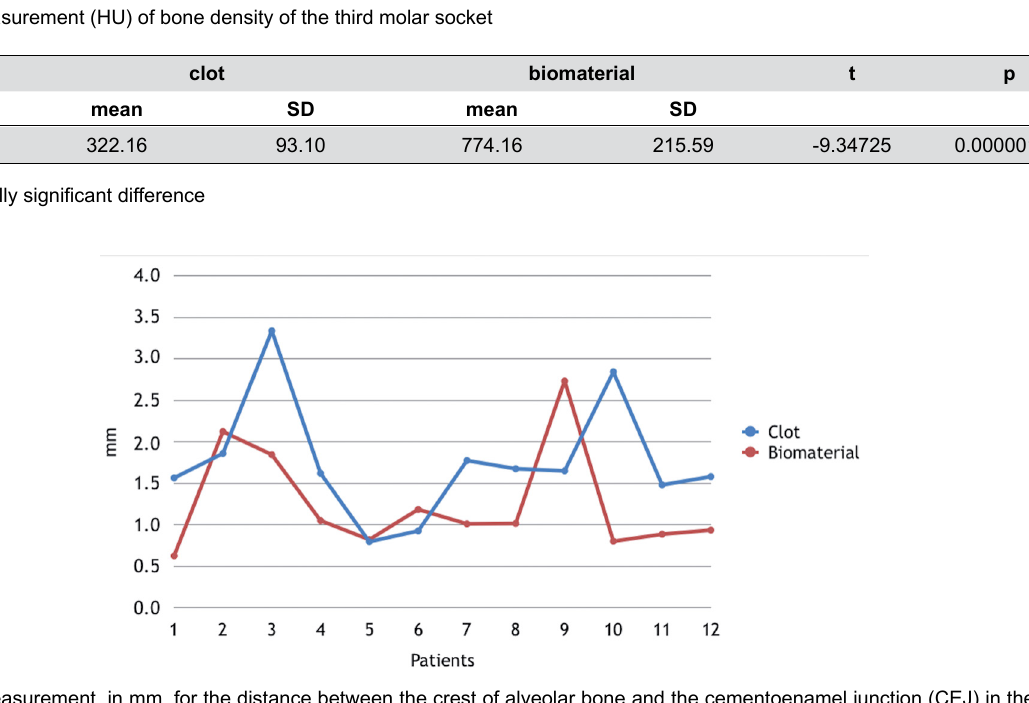
Figure 4- Measurement, in mm, for the distance between the crest of alveolar bone and the cementoenamel junction (CEJ) in the distal second molars in each